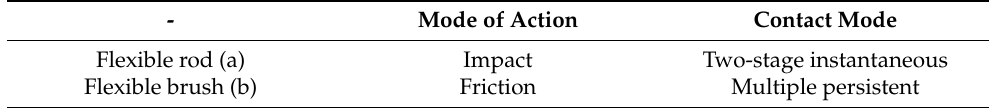
Table 1. Pro-processing of flexible rod and